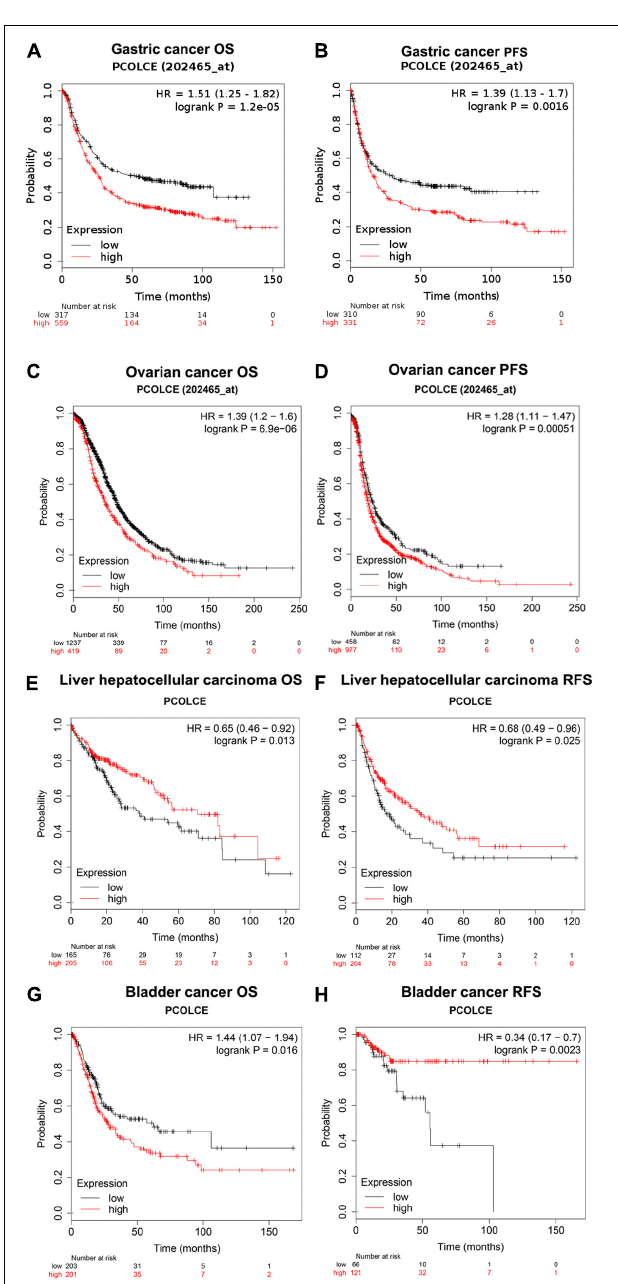
FIGURE 2 | Kaplan–Meier survival curves comparing the high and low expression of PCOLCE in different types of cancer in the Kaplan–Meier plotter databases (A–H) . (A–D) Survival curves of OS and PFS survival curves of gastric cancer and ovarian cancer. (E–H) Survival curves of OS and RFS survival curves of liver hepatocellular carcinoma and bladder cancer. OS, overall survival; DFS, progress-free survival; RFS, relapse-free survival.